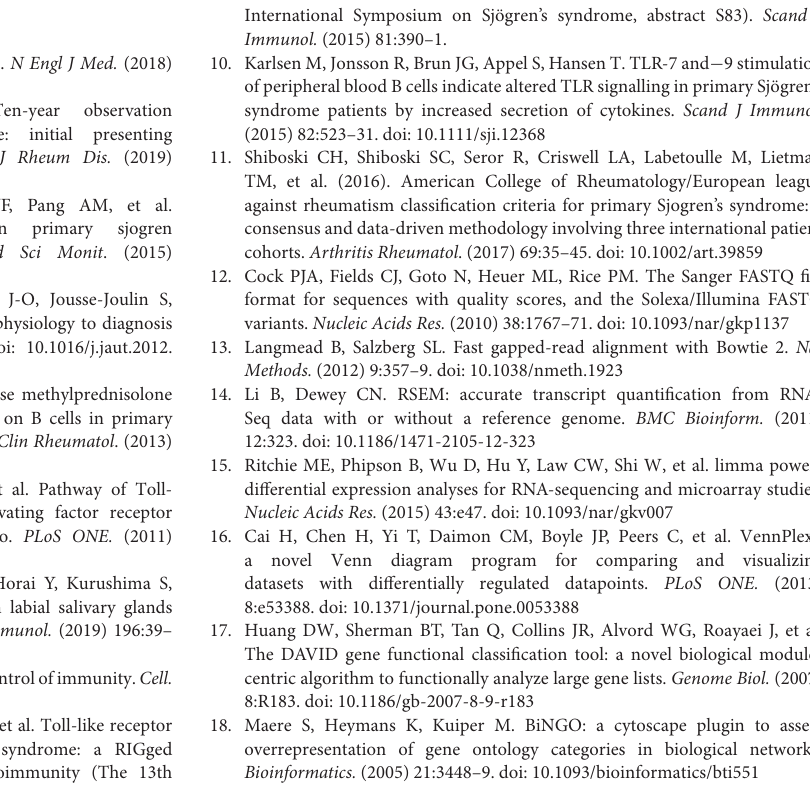
Supplementary Figure 2 | Pathway analysis of 19 differentially expressed genes (DEGs) in pSS associated thrombocytopenia. (A) Bar-plot of relevant and